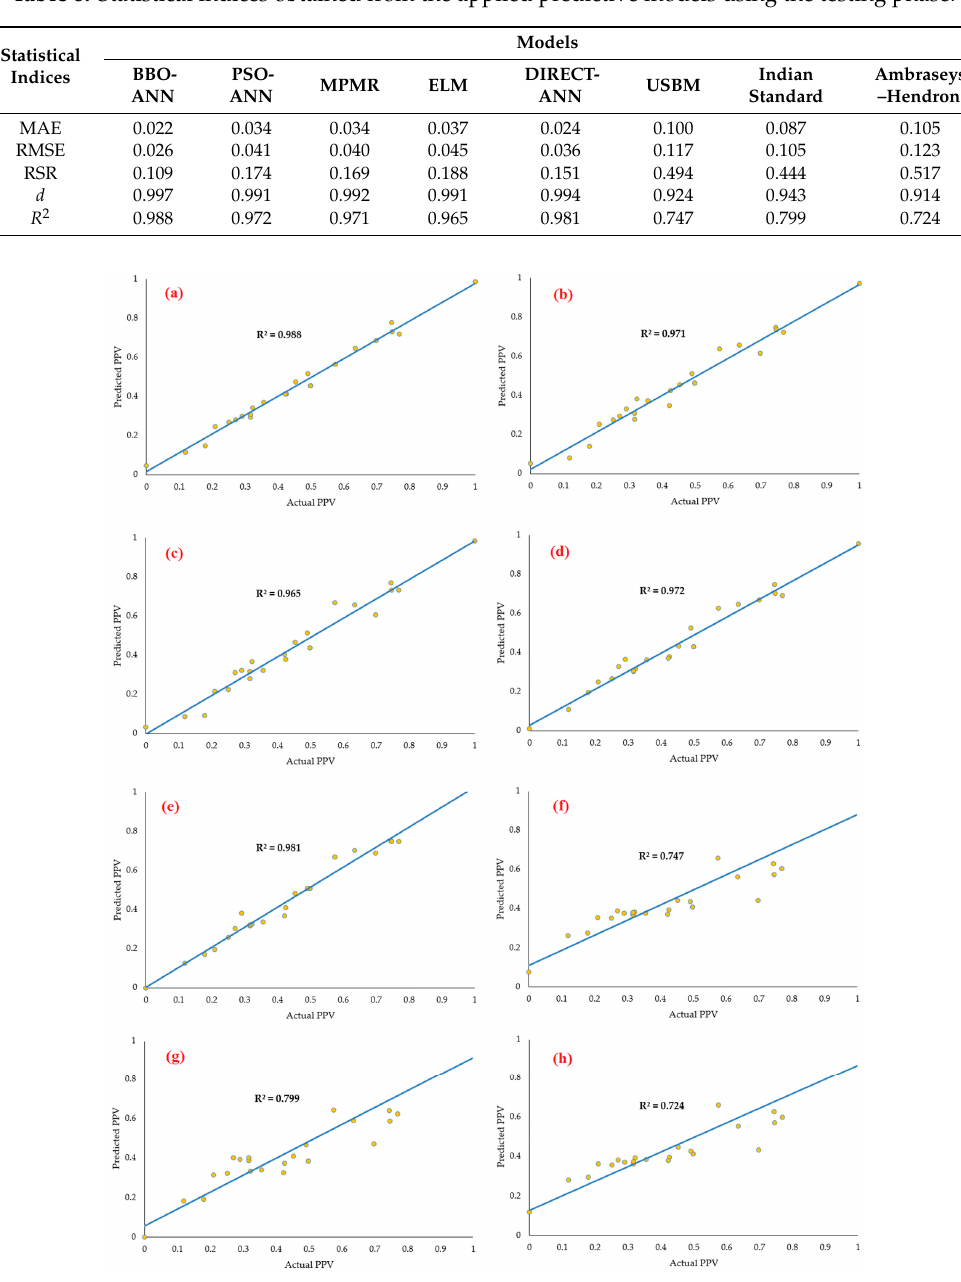
Table 8. Statistical indices obtained from the applied predictive models using the testing phase.